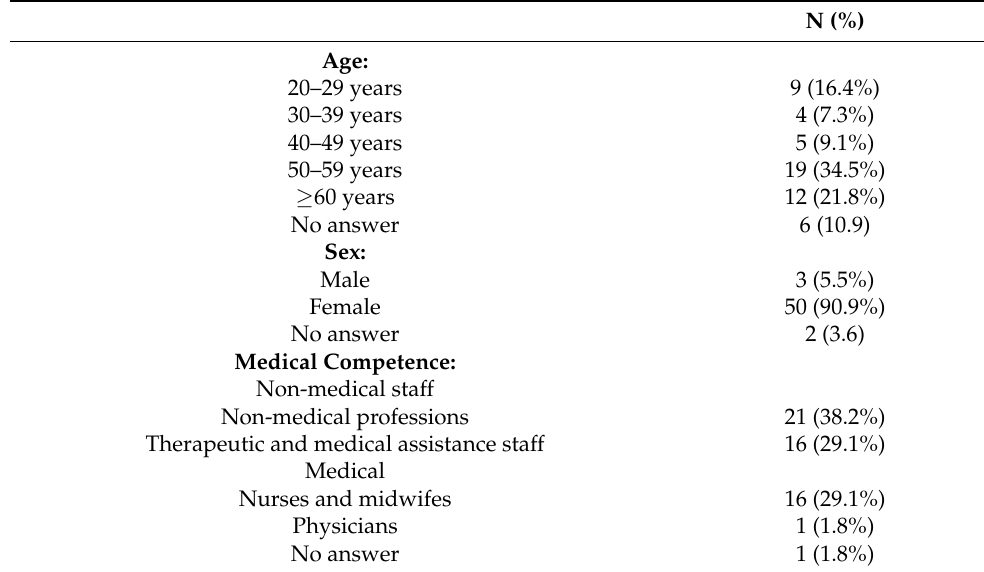
Table 1. Characteristics of participants of the Last Aid course (n =